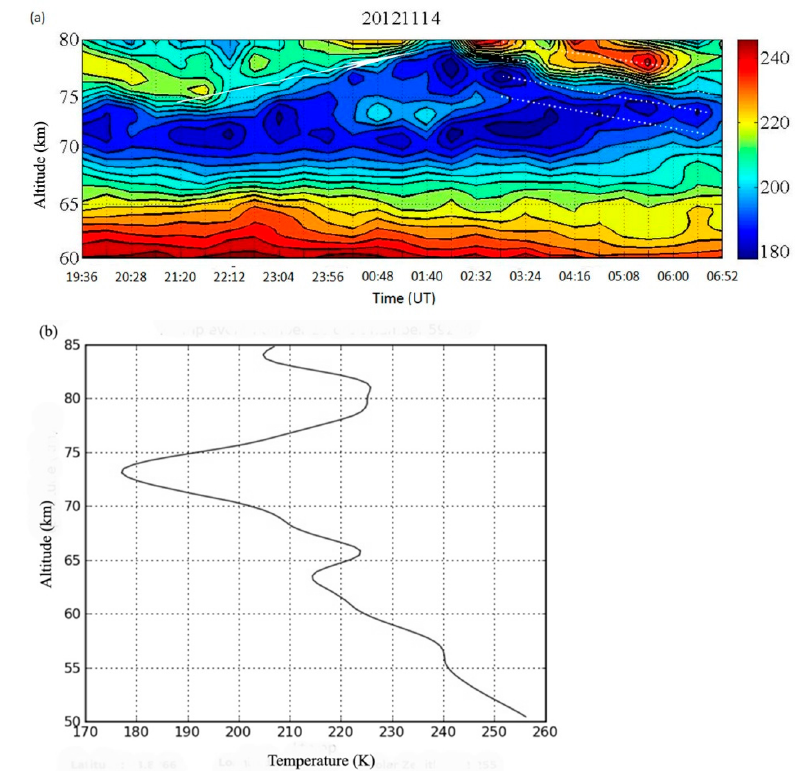
Figure 5. ( a ) MIL case profiles on 14 November 2012: a split bi-MIL emerged at 19:36, and the “white arrow” and “dashed line” indicate the downward and upward tendencies of this case, respectively ( b ). The reference TIMED/SABER data at 43.0° N, 115.8° E of a vertical resolution at 2 km, solar zenith 137.255, event 18, orbit number 59250.